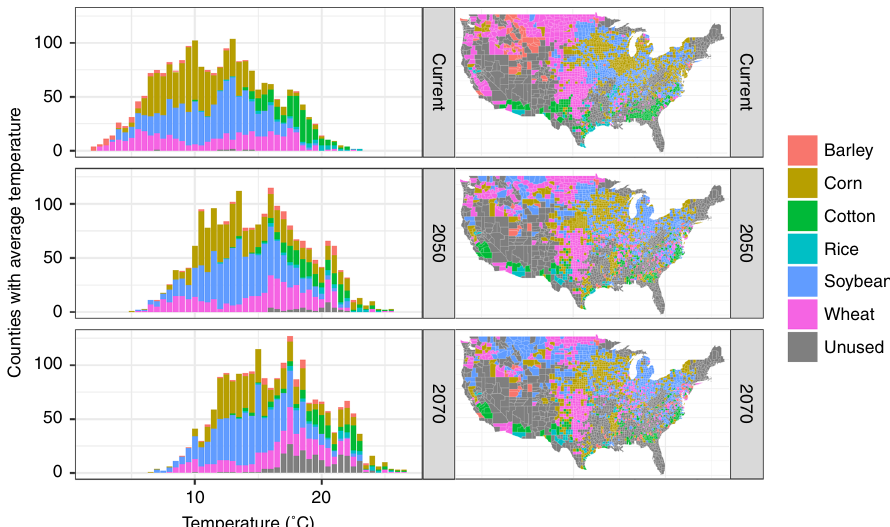
Fig. 2 Optimized crop patterns for each period across temperature and space. Periods are shown on different rows, and the distribution across temperature is shown on the left and across space on the right. When plotted as a distribution across temperature, the climatic annual mean temperature of each county is used, and the distribution is across counties. Unused (gray) regions are displayed where none of the six crops are planted at baseline or where total pro fi ts are maximized by leaving land fallow later in the